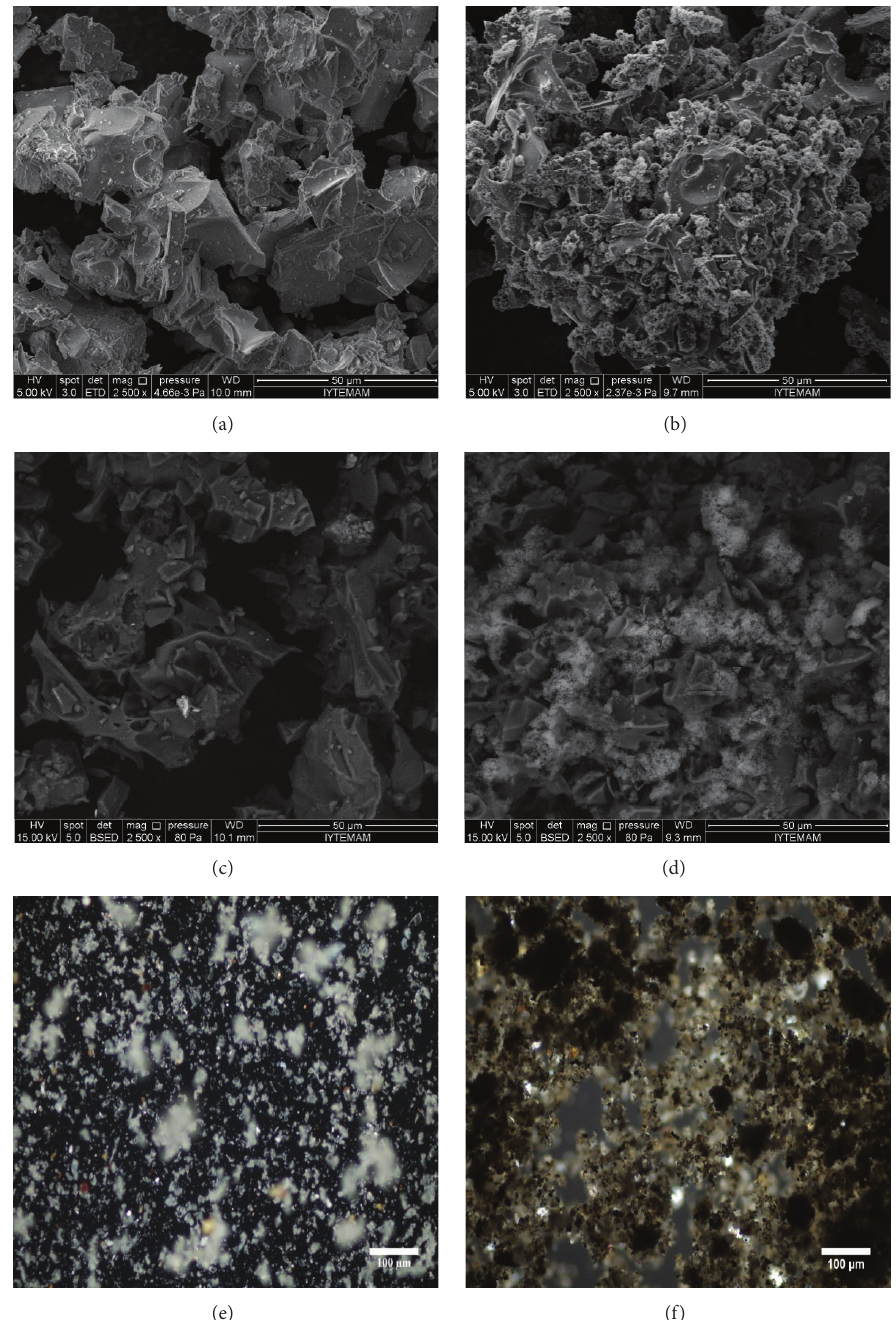
Figure 1: SEM images of bare pumice in different magnifications and detectors (a and c) and P-nZVI (b and d). Bare pumice (e) and P-nZVI (f) images obtained using